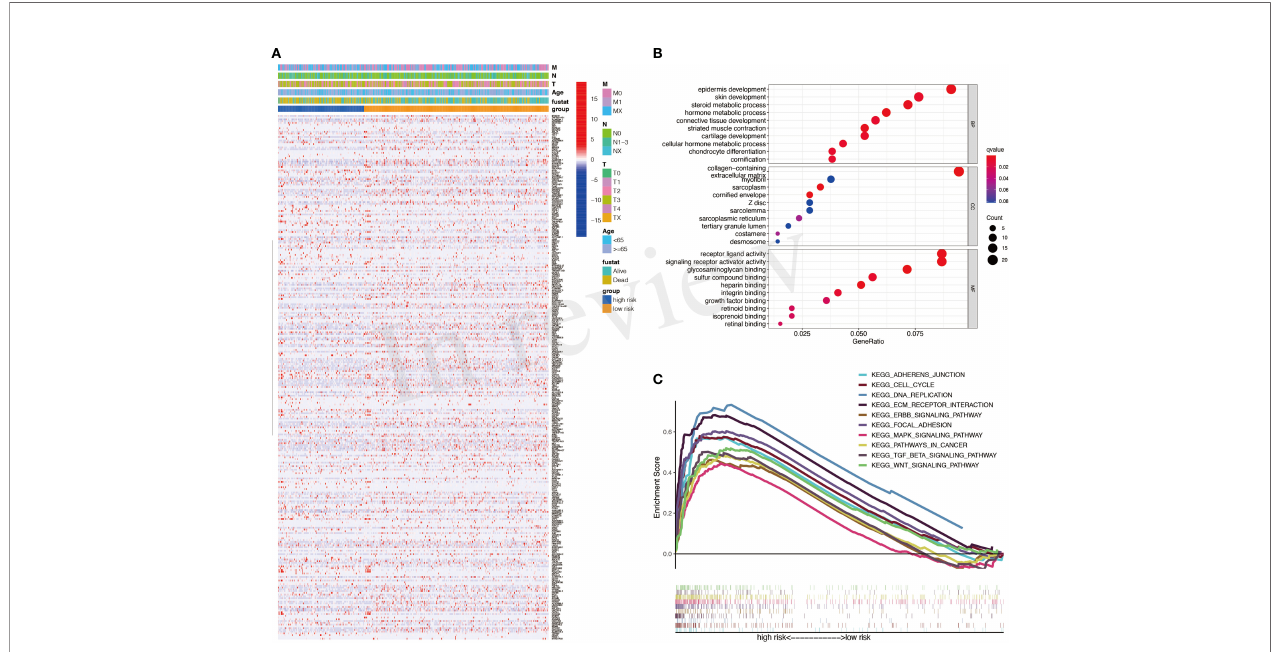
FIGURE 4 | Differentially expressed genes (DEGs) between high- and low-risk groups. (A) A heatmap for DEGs between high- and low-risk groups. (B) Gene Ontology (GO) analysis for DEGs. (C) Activated pathways analyzed by gene set enrichment analysis (GSEA).